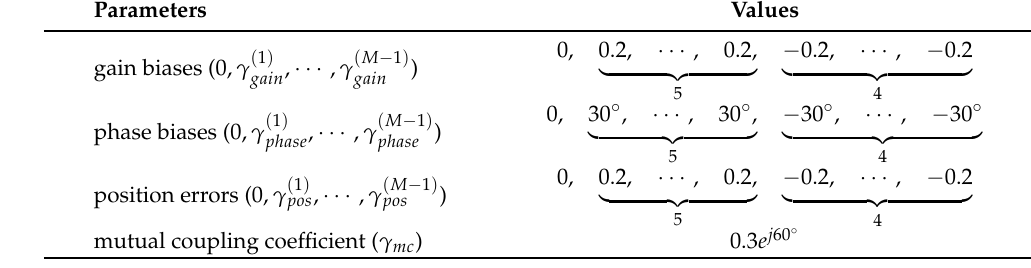
Table 4. Simulation parameters of array imperfections. Parameters